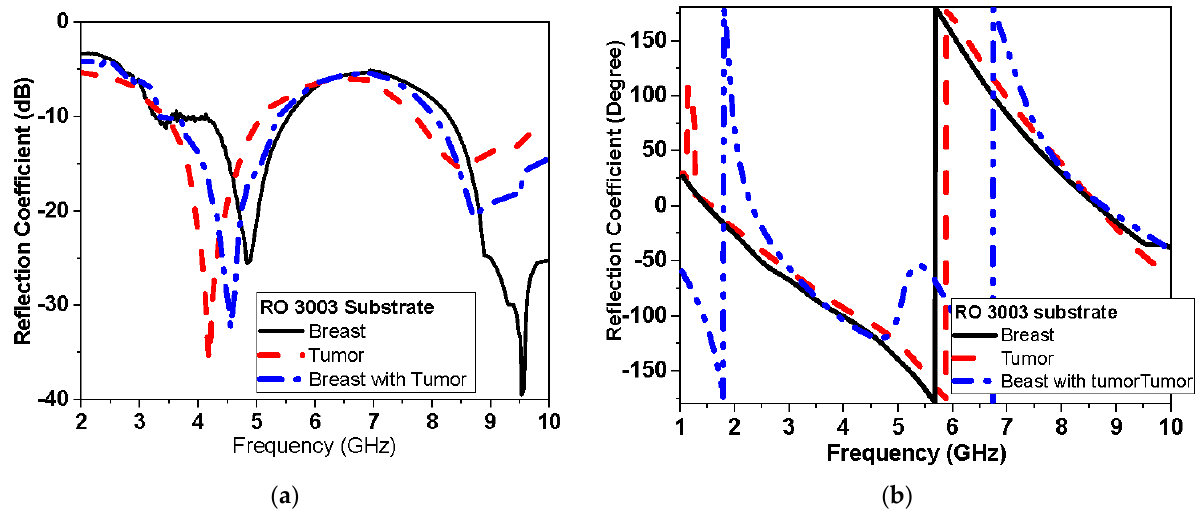
Figure 18. Measured |S 11 | of flexible Roger substrate antenna performance with breast phantom and tumor: ( a ) magnitude and ( b ) phase.